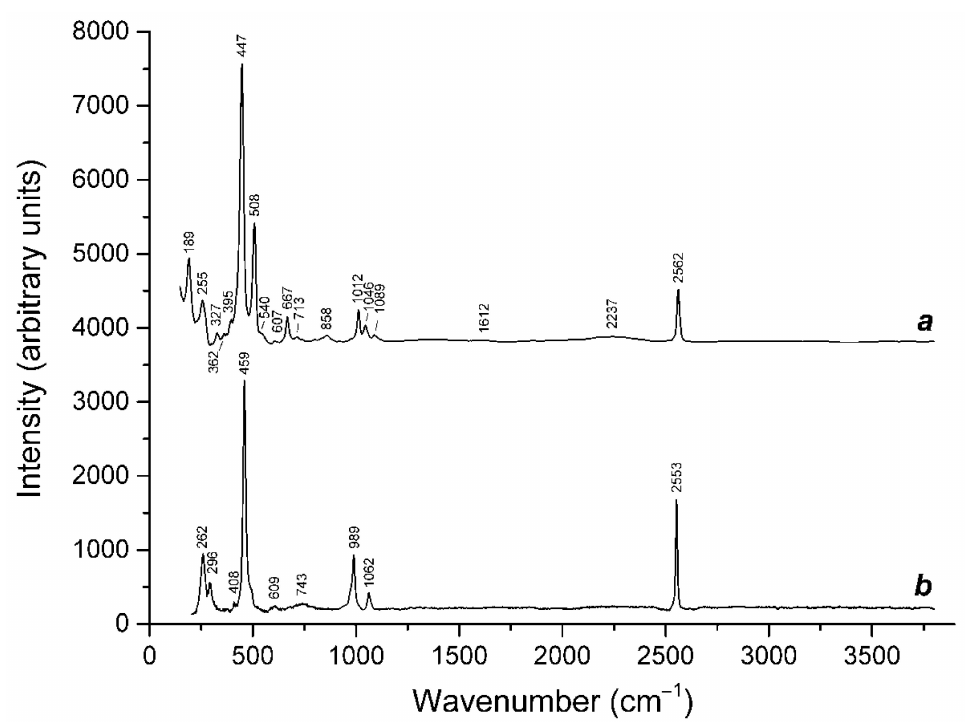
Figure 10. Raman spectra of ( a ) red–orange sulfhydrylbystrite (Sample 12) and ( b ) sapozhnikovite Na 8 (Al 6 Si 6 O 24 )(HS) 2 from the Lovozero alkaline massif, Kola Peninsula, Russia. Baselines of both spectra are corrected.